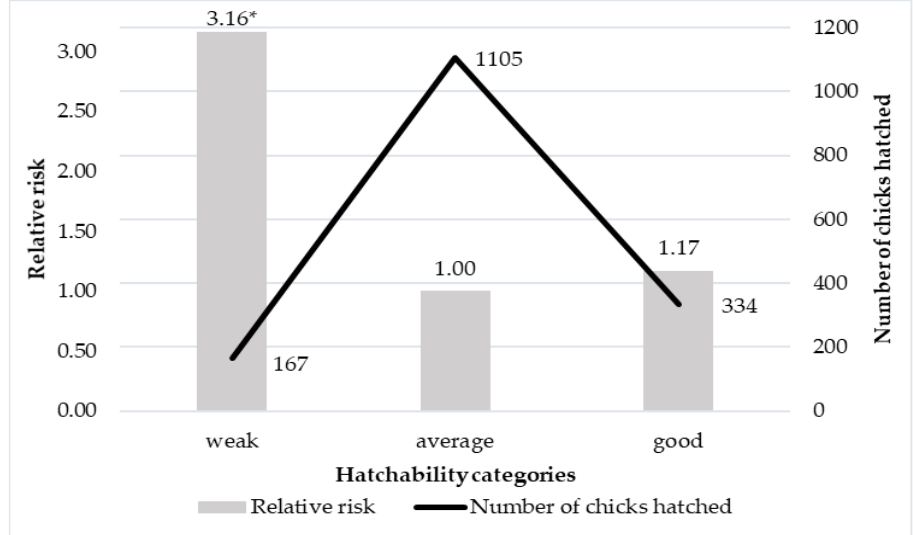
Figure 2. The effect of hatching order in the year on the relative risk of total loss. *Statistically sig- nificant difference from the reference group ( p ≤ 0 .05).